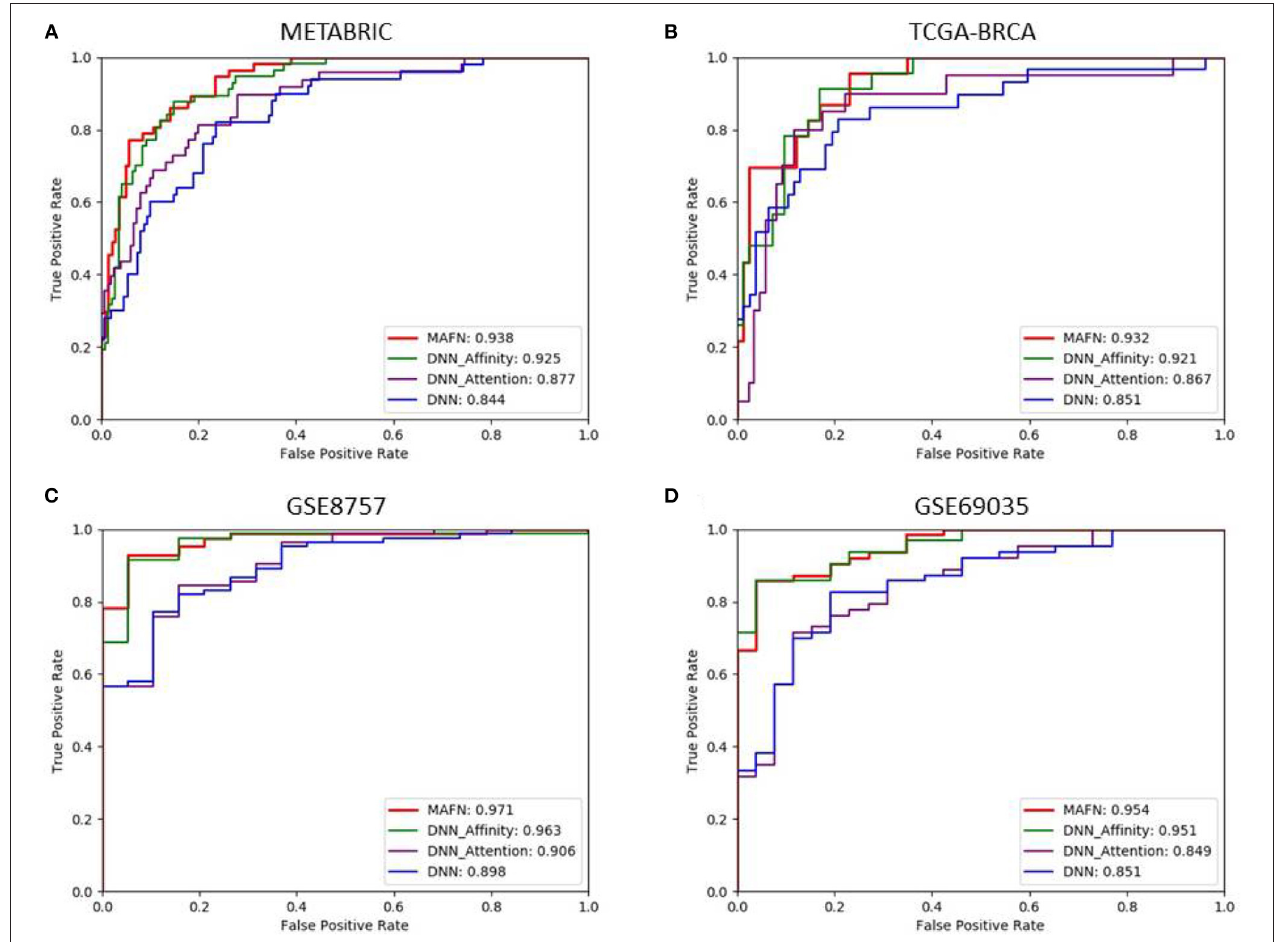
FIGURE 3 | Comparison of ROC curves produced by multimodal affinity fusion network (MAFN) and single module. (A) is the result in METABRIC dataset; (B) is the result in TCGA-BRCA dataset; (C) is the result in GSE8757 dataset; (D) is the result in GSE69035 dataset.